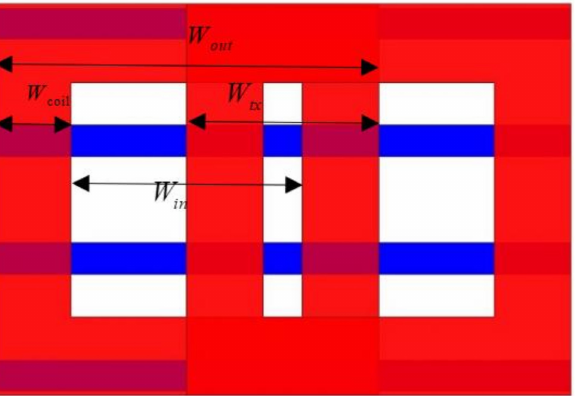
Figure 19. Key geometric parameters of the bipolar structure transformer.